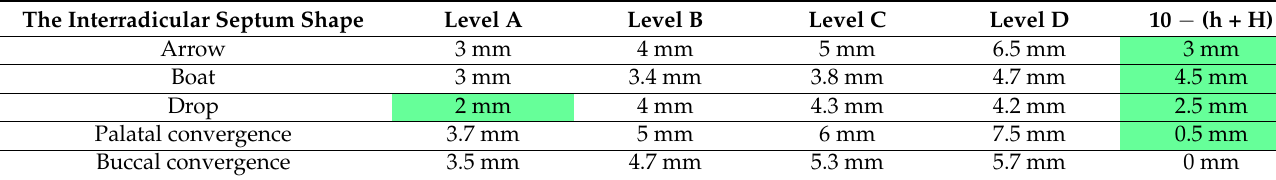
Table 3. The relationship between the average values of the IRS parameters obtained in the coronal view and the minimal recommended IRS diameters for the first maxillary molars according to the IRS shape (critical points are colored). The last column represents the value of vertical diameter required to achieve implant stability (above 10 mm).